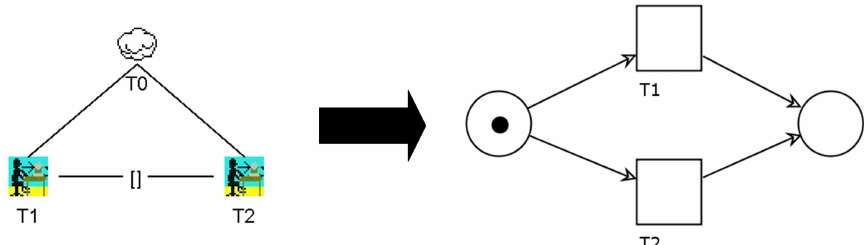
Figure 4. Transforming the choice-operator from CTT to PN